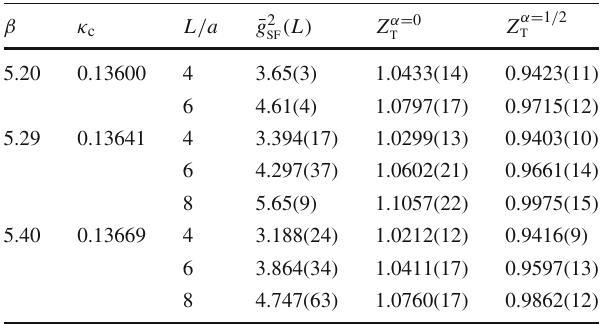
( g 2 , L / a ) at L = 1 /μ T 0